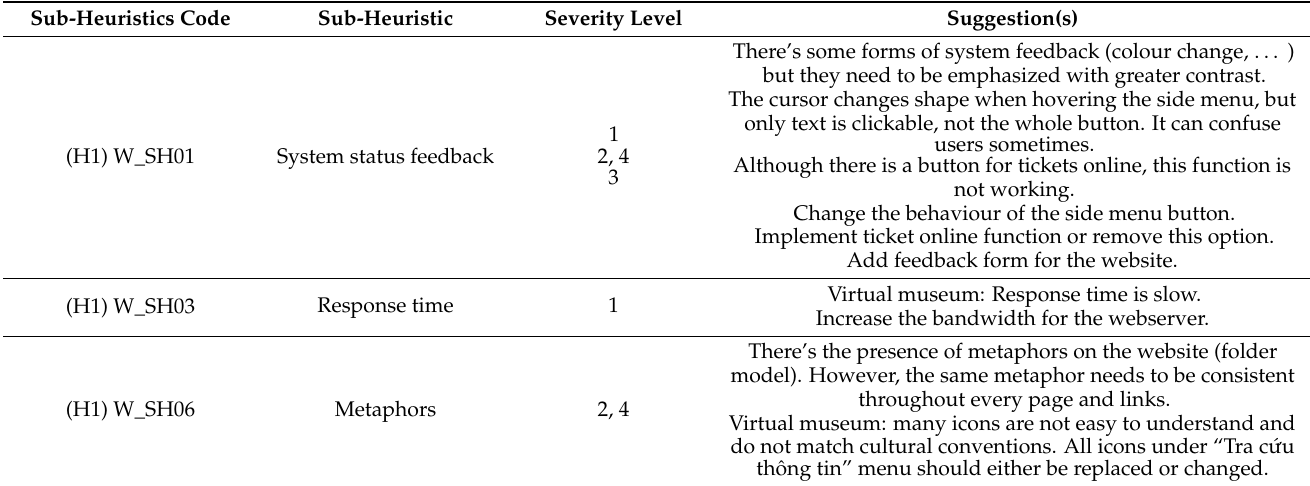
Table A6. UX Experts’ Suggestions for the VNMH’s